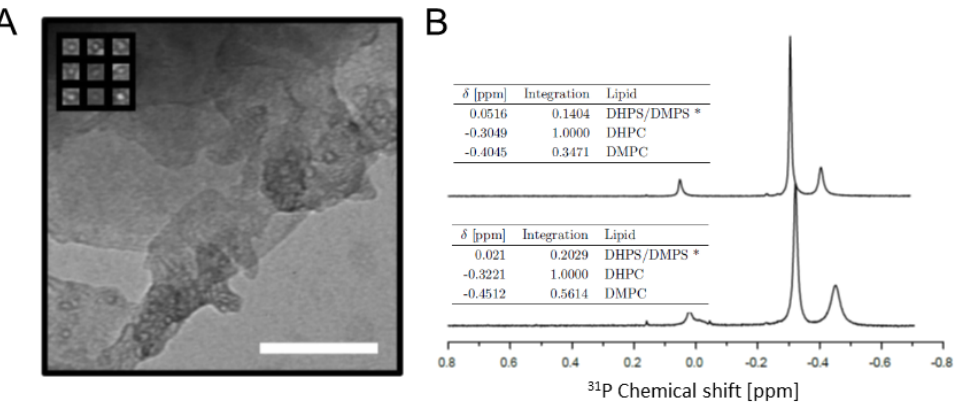
Figure 4. Characterization of bicelles: ( A ) TEM image of bicelles adsorbed to carbon mesh copper grid and stained with UA. The inset contains a selection of bicelle images. The scale bar is 100 nm. ( B ) 31 P-NMR of bicelles and A-Cage-C in the presence of bicelles. The plot shows proton decoupled 31 P-NMR spectra of the following samples. Top: 45 mM bicelles, pH 5.5. Bottom: 100 mM bicelles and 1.1 mM A-Cage-C, pH 4.5. Table insets list DHPS, DMPS and DHPC chemical shifts for each major peak in the spectra, as well as peak integration volumes relative to the DHPC peak volume.